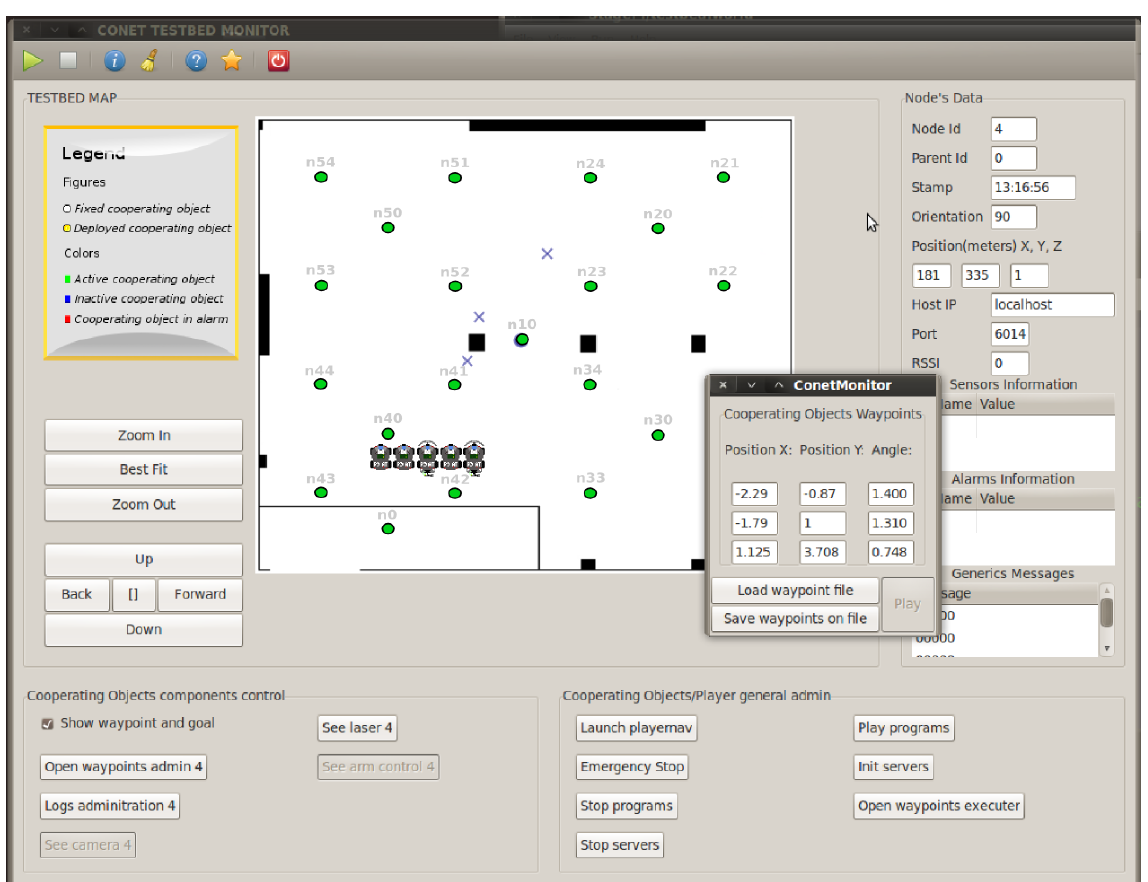
Figure 7. Snapshot of the testbed GUI for remote experiment control and